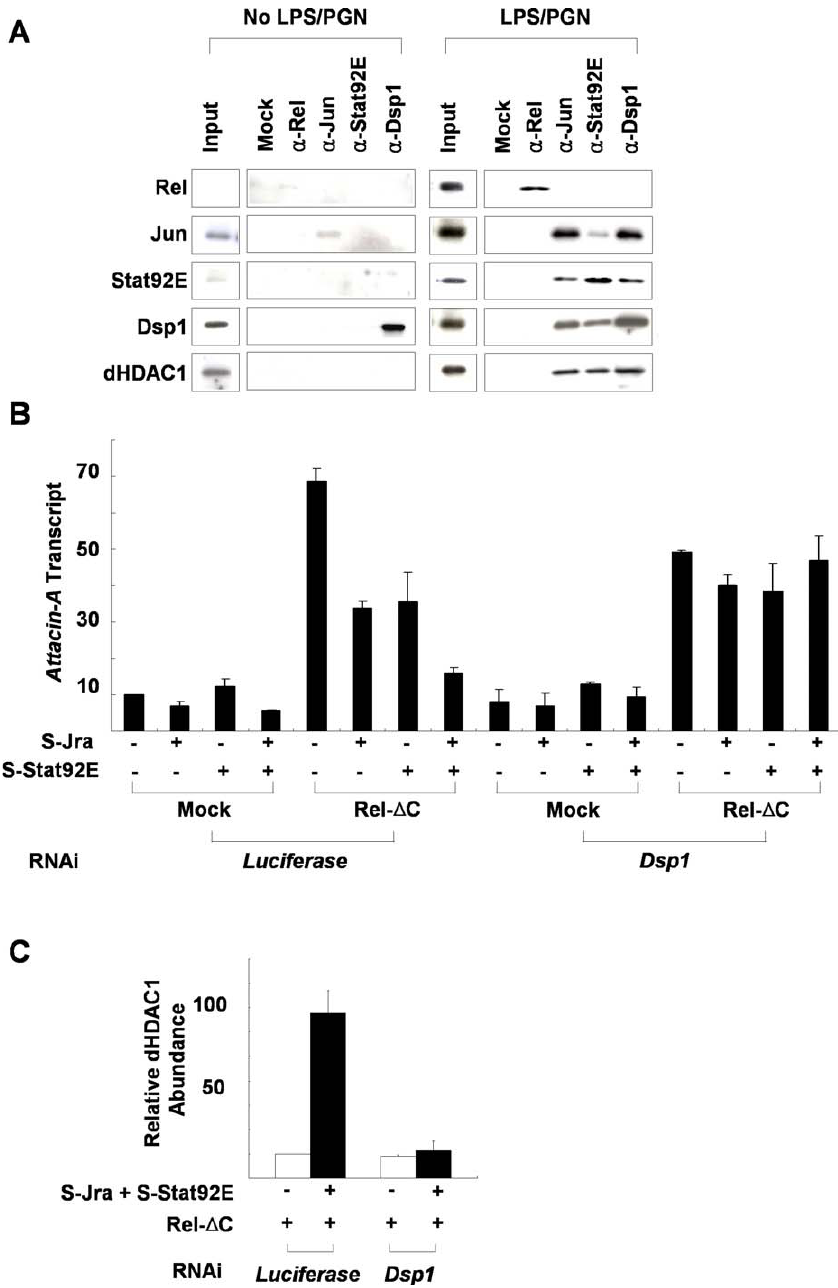
Figure 5. Dsp1 Interacts with Jra and Stat92E to Form a Repressosome Complex (A) Co-immunoprecipitation of Relish, Jra, Stat92E, and Dsp1. Nuclear extracts prepared from SL2 cells with (right panel) or without (left panel) LPS/PGN (10 l g/ml for 45 min) treatment were immunoprecipitated with the antibodies indicated at the top of the figure, and the amounts of the proteins in the pellets were measured by immunoblot analysis with the antibodies indicated on the left. For co-immunoprecipitation of Relish, Jra, and Stat92E, 10- l g aliquots of nuclear extracts were used, whereas for Dsp1, 3- l g aliquots were used. Five percent of the amount of nuclear extract used in each immunoprecipitation assay is shown as Input. (B) Regulation of Attacin-A transcription by ectopic expression of transcription factors. The N-terminal half of Relish that is competent as a transcriptional activator (Rel- D C), epitope-tagged Jra (S-Jra), and Stat92E (S-Stat92E) expression constructs were transfected into SL2 cells as indicated at the bottom of the figure. After induction of the recombinant proteins, the levels of Attacin-A transcripts relative to those of RpL32 were measured by real-time PCR analysis in three independent experiments. (C) ChIP assays of the Attacin-A promoter with anti-dHDAC1 antibody. SL2 cells pretreated with Luciferase dsRNA (control) or Dsp1 dsRNA (Dsp1-) were transfected with expression constructs for Rel- D C, S-Jra, and S-Stat92E as indicated at the bottom, and the average amounts of Attacin-A promoter fragments co-precipitated with anti-dHDAC1 antibody after induction of the transfected transcription factors were measured by real time PCR analysis in three independent experiments.